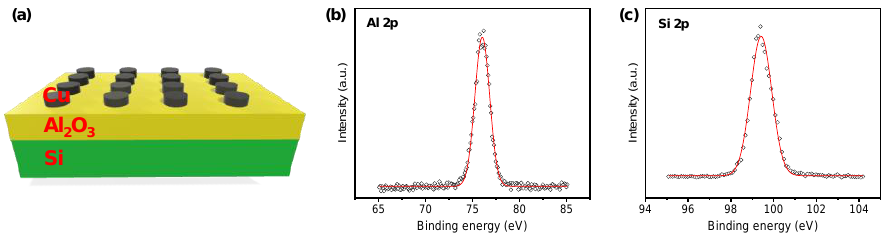
Figure 1. ( a ) Device schematics of Cu/Al 2 O 3 /Si device. ( b ) XPS Al 2p and ( c ) XPS Si 2p of Al 2 O 3 /Si stack.